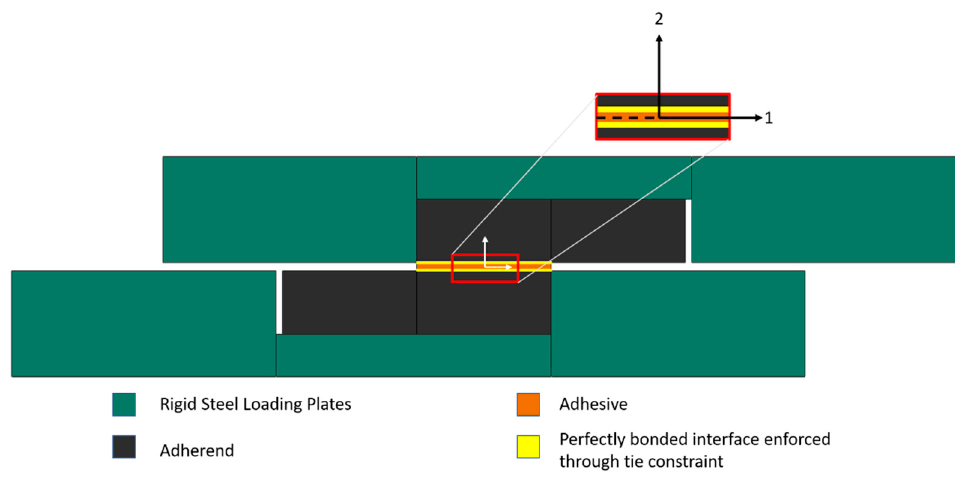
Figure 7. Block shear test modeled using plane strain elements in ABAQUS. Contact condition is applied between the adherend and the rigid steel loading plates.